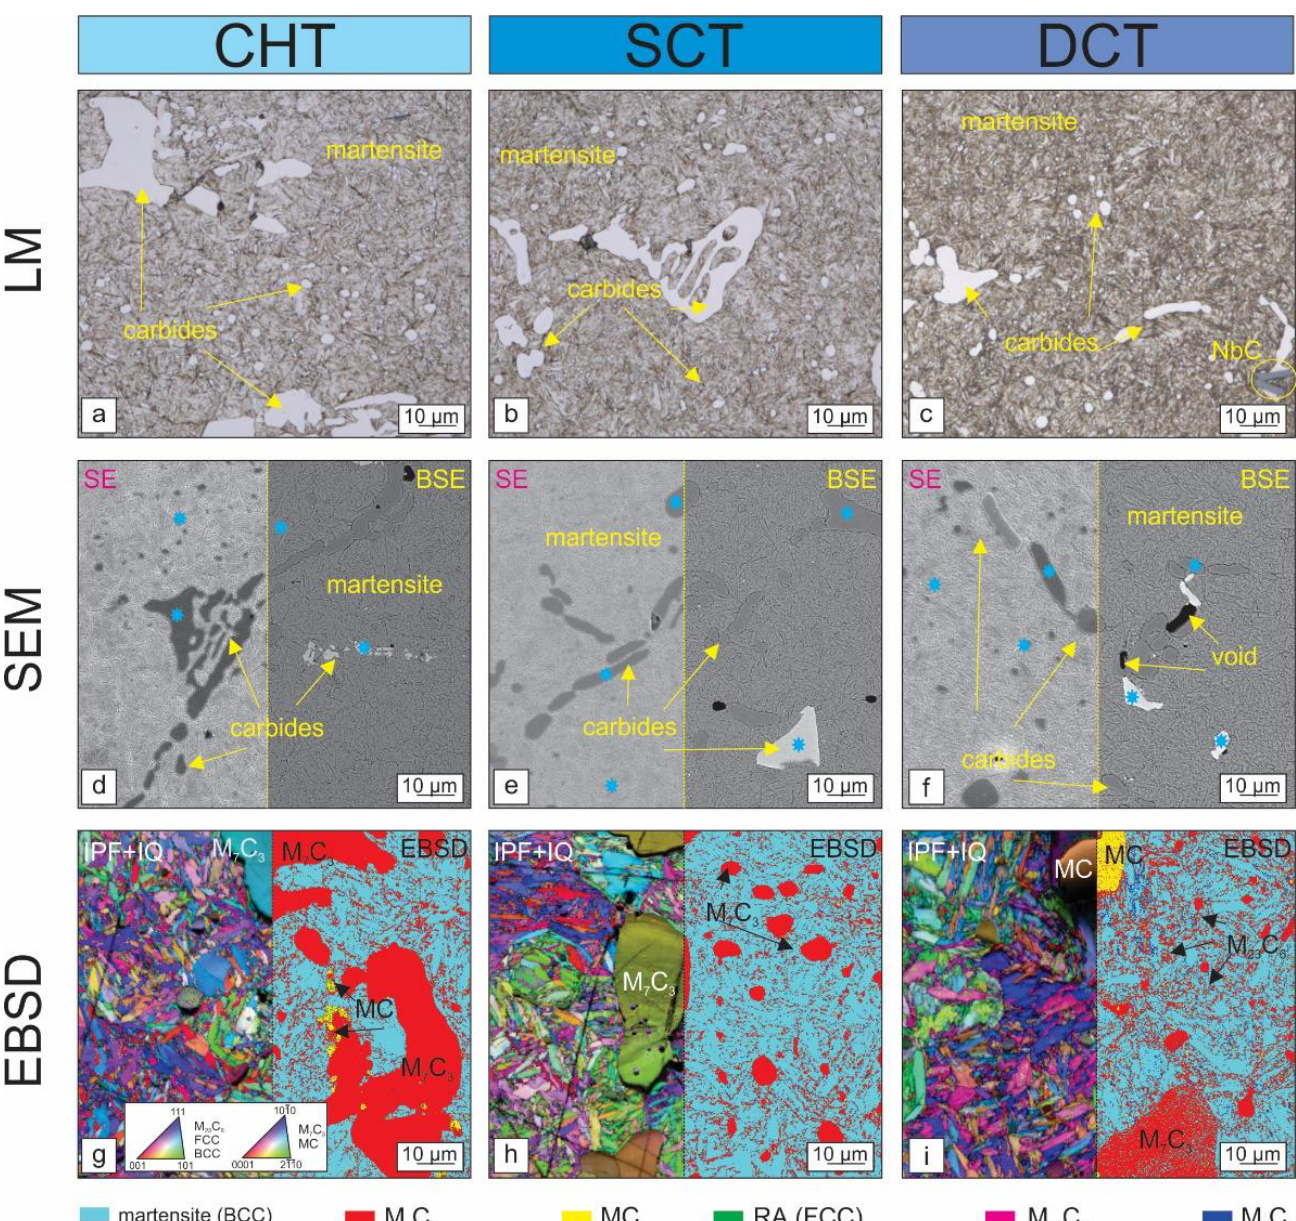
Figure 2. The microstructure of all three heat treatment groups CHT-conventional heat treatment ( a , d , g ), SCT-shallow cryogenic treatment ( b , e , h ) and DCT-deep cryogenic treatment ( c , f , i ) observed with light microscopy (LM), scanning electron microscopy (SEM) under secondary electrons (SE) and backscatter electrons (BSE) and with electron backscatter diffraction (EBSD) represented through inverse pole figures (IPF-+IQ). The phases, which are presented are martensite (BCC), retained austenite (RA) and different carbides (MC, M 7 C 3 , M 23 C 6 and M 3 C 2 ).